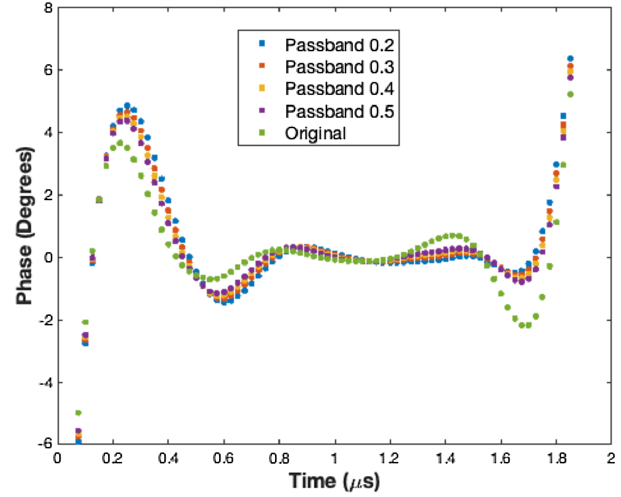
FIG. 18. Transmitter power with detuning, clamping, and band- limited transmitter response. Steady state required power with (continuous) beam shown for comparison. The batch is indicated with vertical dashed lines.